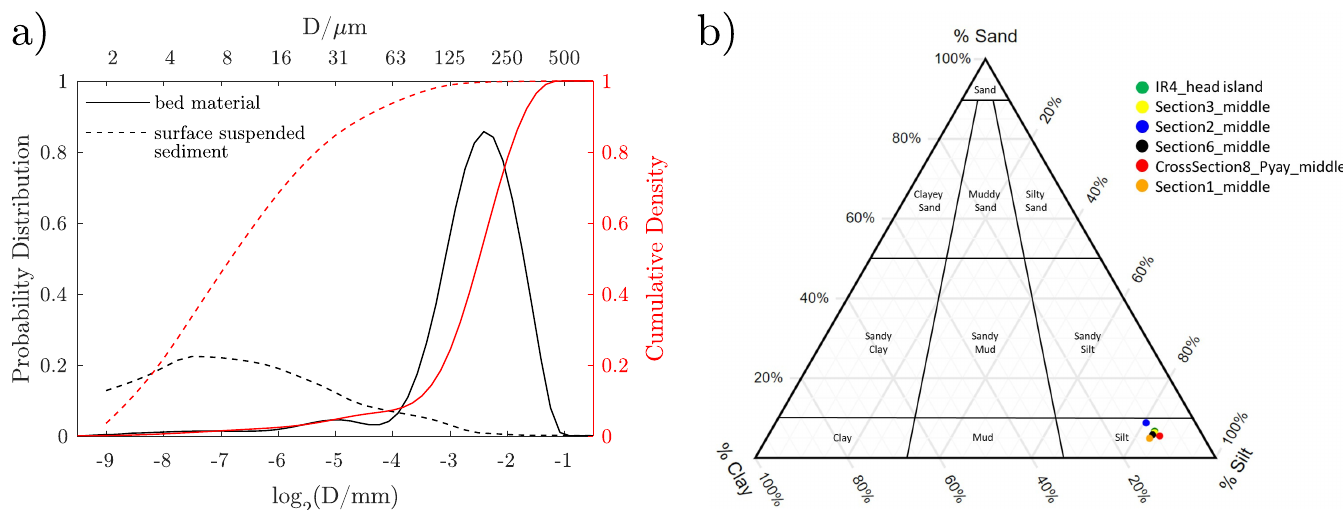
Fig 4. Monthly SSSC of the Ayeyarwady at Pyay, average over the years 2000–2015. Derived from 60 MODIS satellite images per month on average.